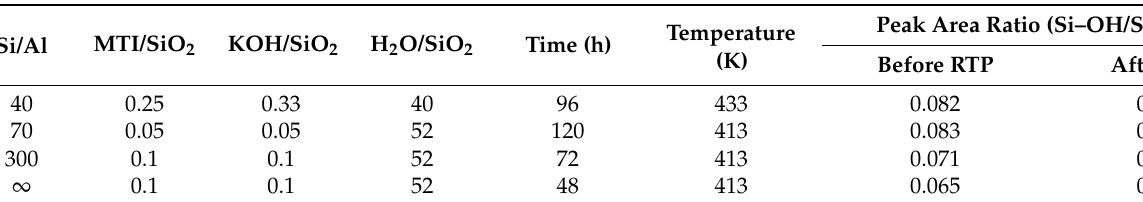
Figure 11. ( a ) Schematic formation of silanol bridges by silanol condensation, and ( b ) FTIR spectrum with deconvoluted peak components using the Gaussian line shape [1,15,23]. Table 4. Synthesis conditions and peak area ratios of silanol concentrations of ZSM-58 crystals with different Si/Al molar ratios with the measured FTIR spectra.